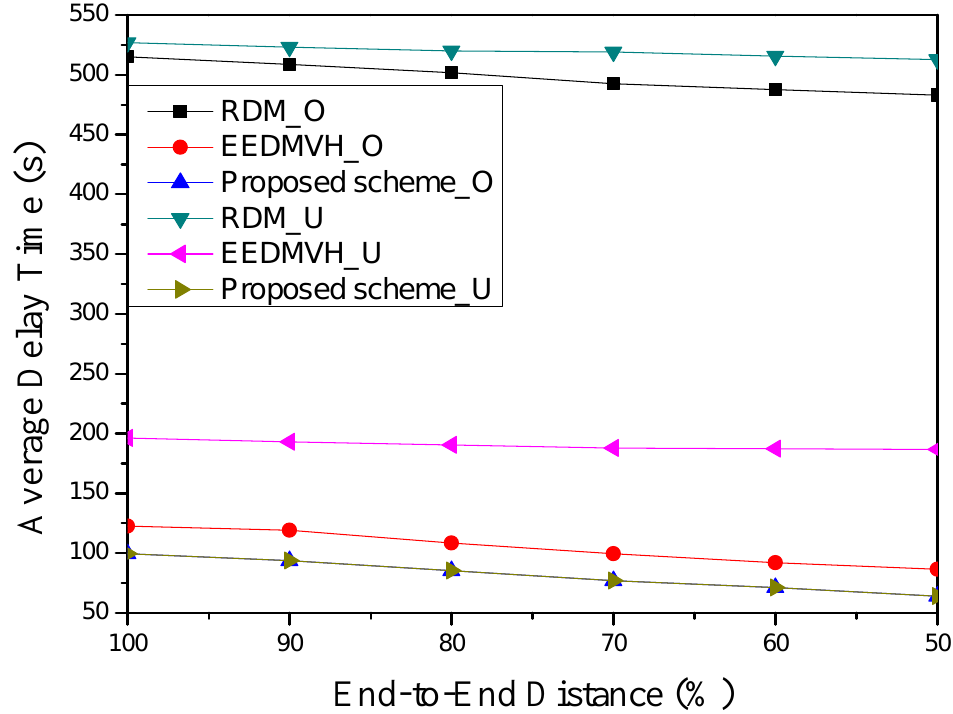
Figure 12. Average delay time according to end-to-end distance. Figure 13 shows the average delay time according to the radio range of a node in the circular model and the horseshoe model. As with other simulation result figures, RDM has the highest average delay time of the simulation targets due to extra delays in hole modeling and detouring transmission time. This research sharply decreases the average delay time according to the radio range through the farthest node selection of greedy forwarding. However, since RDM has additional delay time for the modeling process and the detour delay time according to the hole-modeling area, it has the highest average delay time compared to other simulation research, as shown in Figure 13. Furthermore, among the simulation comparison targets, EEDMVH shows lower average delay time than RDM